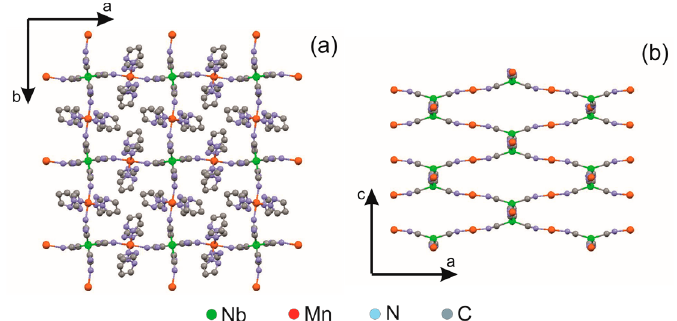
Figure 8. Structure of 2. ( a ) View of the structure along the c (a) and b ( b ) crystallographic axes. For clarity the water molecules, the hydrogen atoms, and all nonbridging cyanido ligands have been removed.